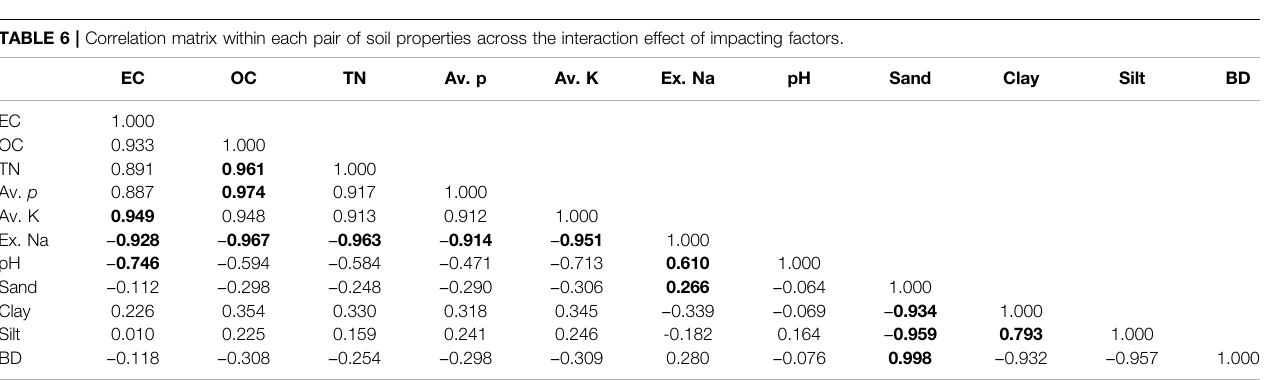
TABLE 6 | Correlation matrix within each pair of soil properties across the interaction effect of impacting